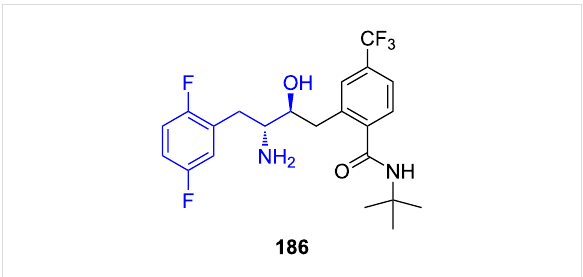
Figure 9: Structure of LY2497282 (186 ) a DPP-4 inhibitor for the treat- ment of type II